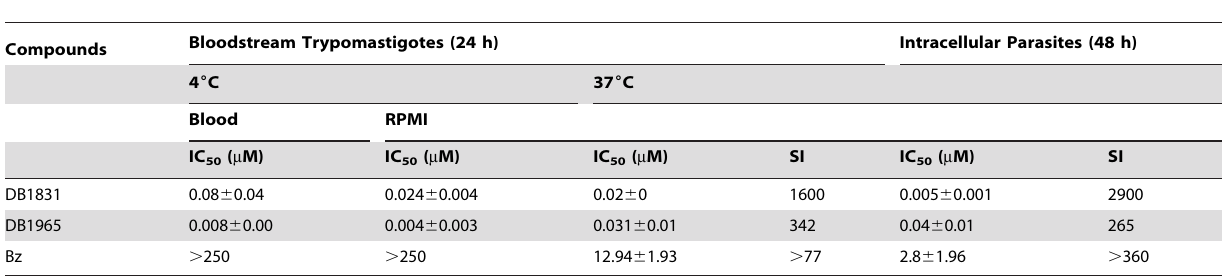
Table 1. Trypanocidal effect of Arylimidamides and Benznidazole against T. cruzi (Y strain).